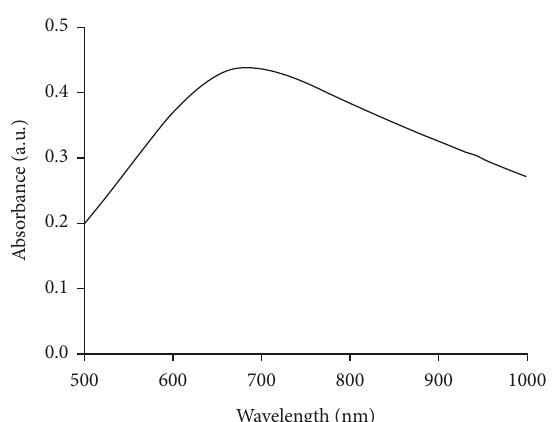
Figure 2: UV-vis absorption spectrum of Prussian blue nanocrystal.